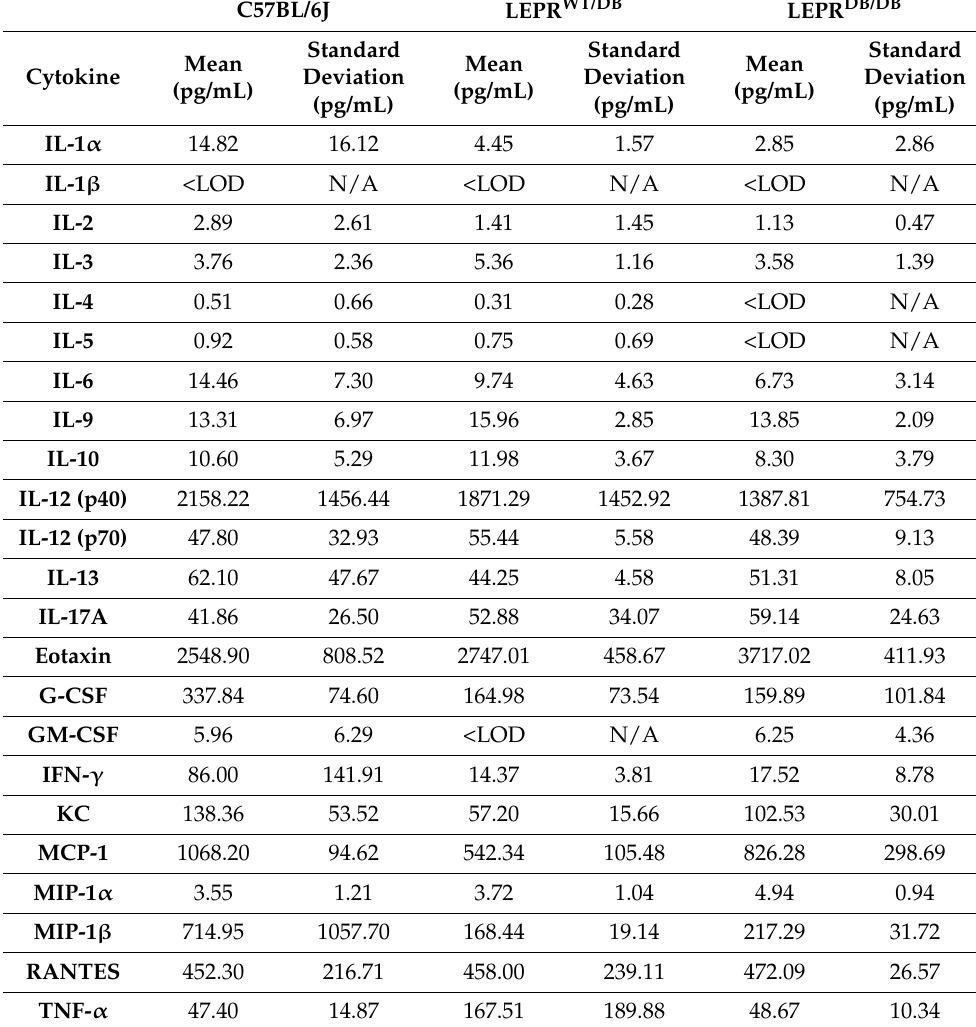
Table 1. Cytokine levels in mice varying in the LEPR mutation and infected with ZIKV. Serum was taken from animals immediately following Aedes aegypti Rockefeller feeding. Serum from each animal was run in duplicate utilizing a mouse multiplex bead assay to determine circulating levels of 23 cytokines. Data are presented as averages of all animals of a given phenotype, alongside standard deviations. LOD: limit of detection; N/A: not